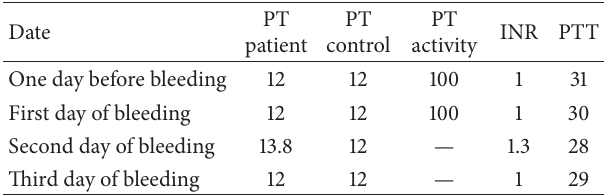
Table 3: Coagulating factor evaluation during bleeding and treat- ment.